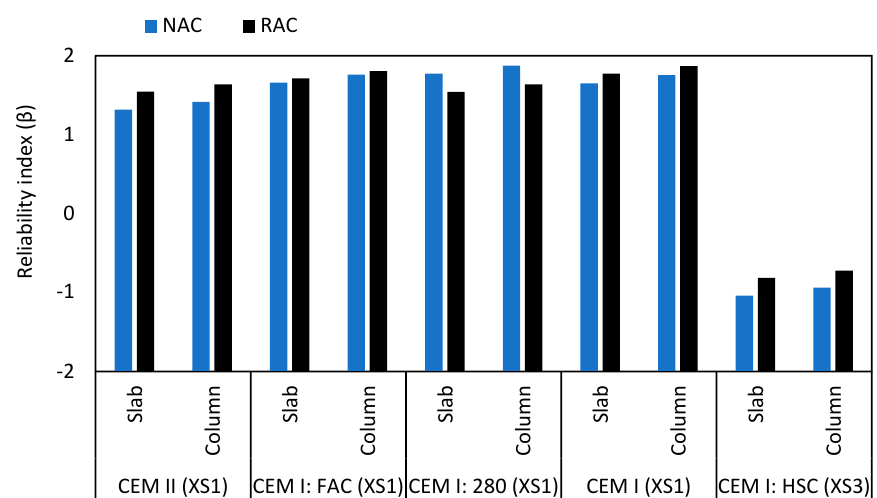
Figure 8. Reliability indices of all cases studies. Cover increases of 5 mm when RA are used.